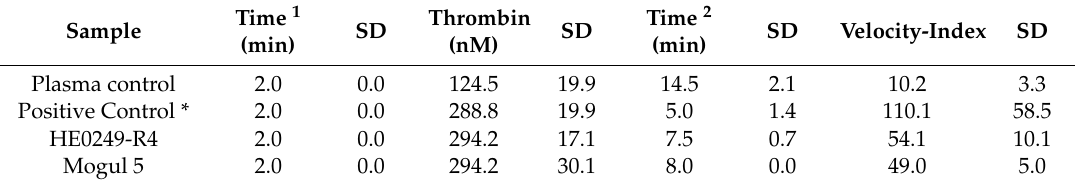
Table 4. Results of thrombin generation assay of hydroentangled nonwoven lead prospect with controls a .